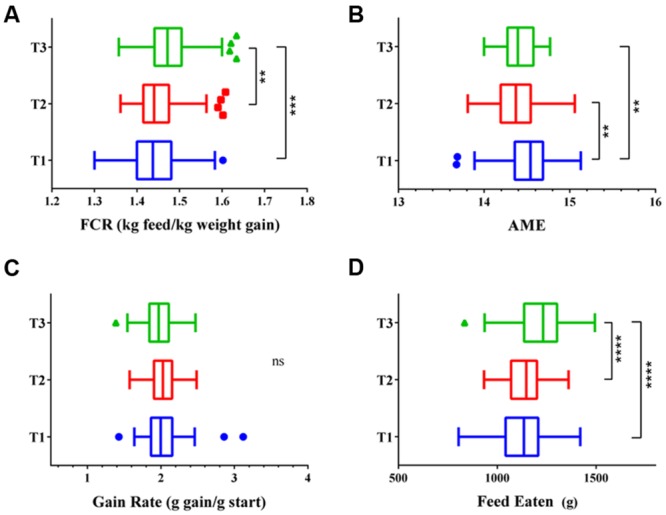
Performance of the three flocks shown as (A) feed conversion ratio (FCR), (B) apparent metabolisable energy (AME), (C) gain rate (GR), and (D) feed eaten (FE). Trial 1 is shown in blue, Trial 2 in red, and Trial 3 in green. ∗p < 0.01, ∗∗p < 0.005, ∗∗∗p < 0.001